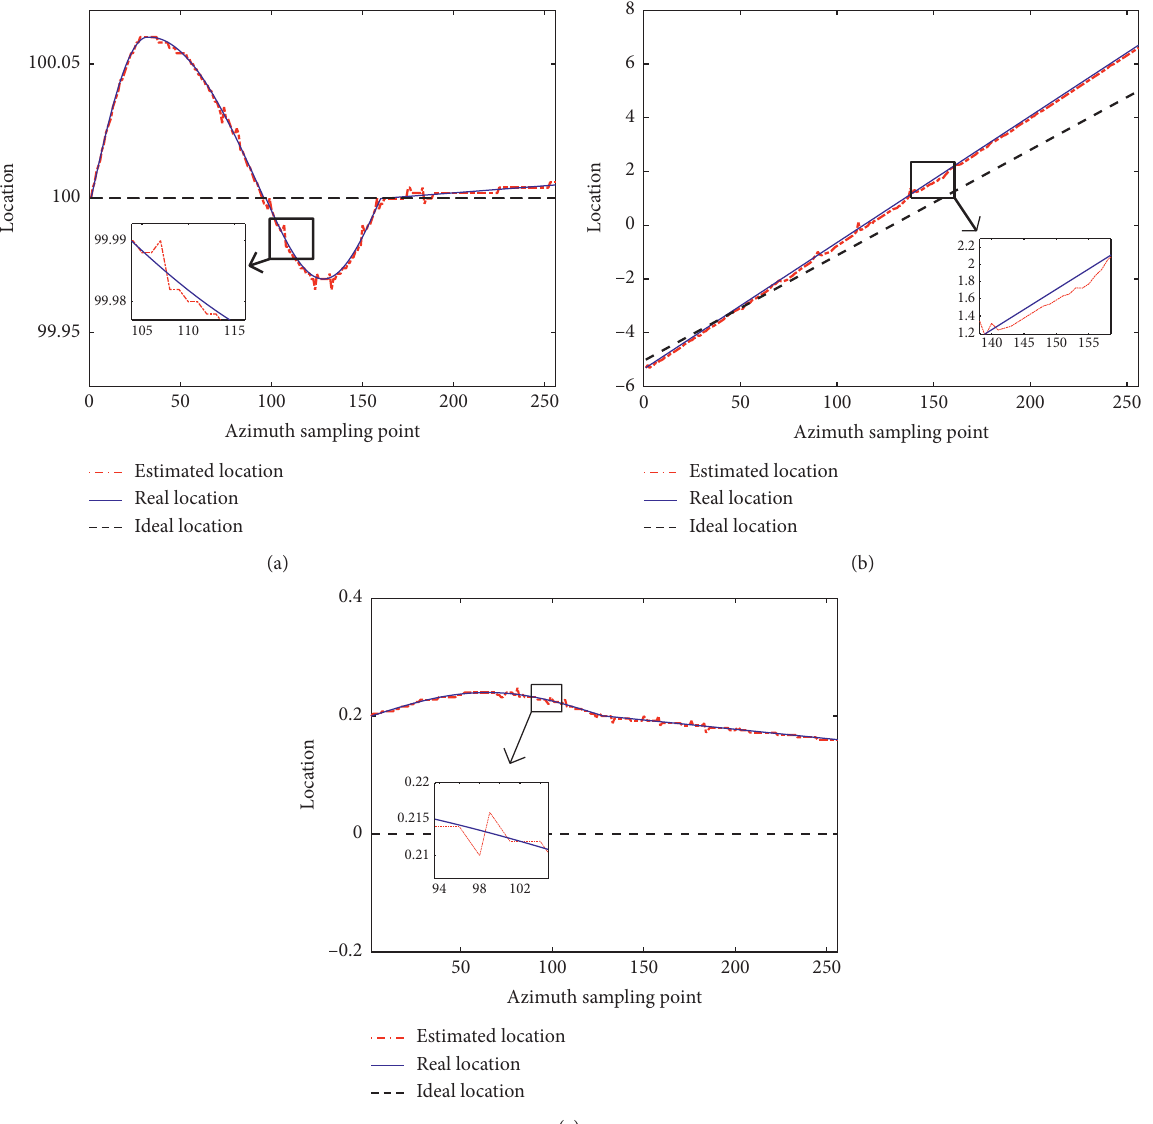
Figure 7: Estimation results of observation position. (a) x coordinates. (b) y coordinates. (c) z